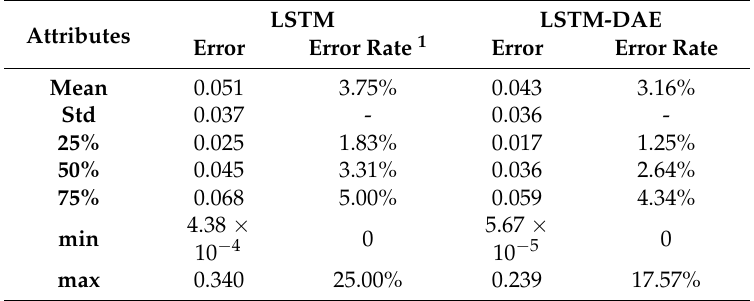
Table 2. Comparison of stride-length estimation using LSTM and LSTM–DAE.